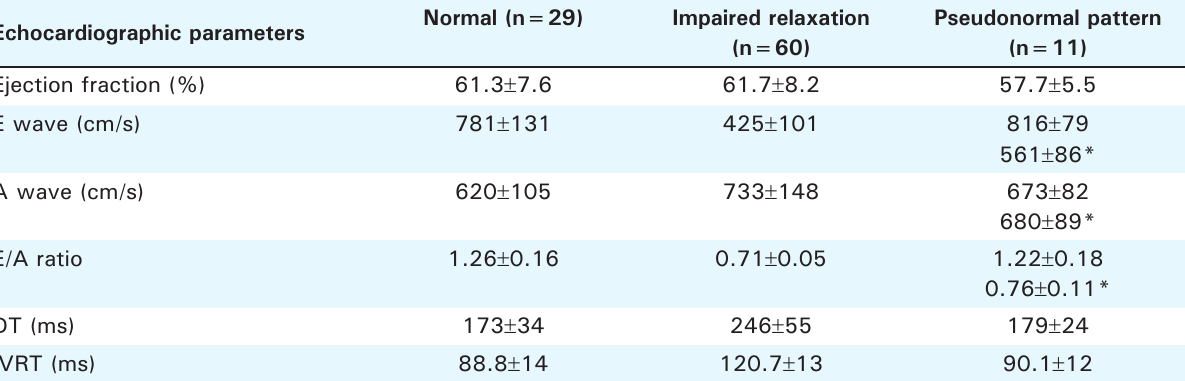
table 2. comparison of echocardiographic parameters between subjects with normal and those with diastolic